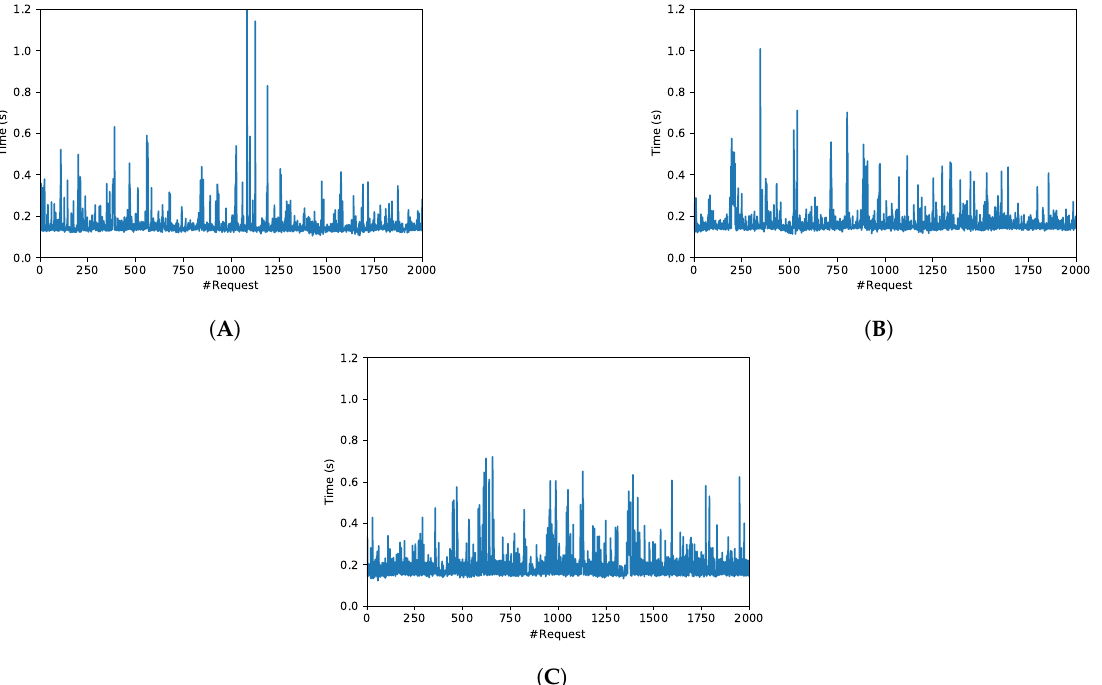
Figure 13. Response time in OrbitDB for ( A ) Scenario A, ( B ) Scenario B and ( C ) Scenario C.